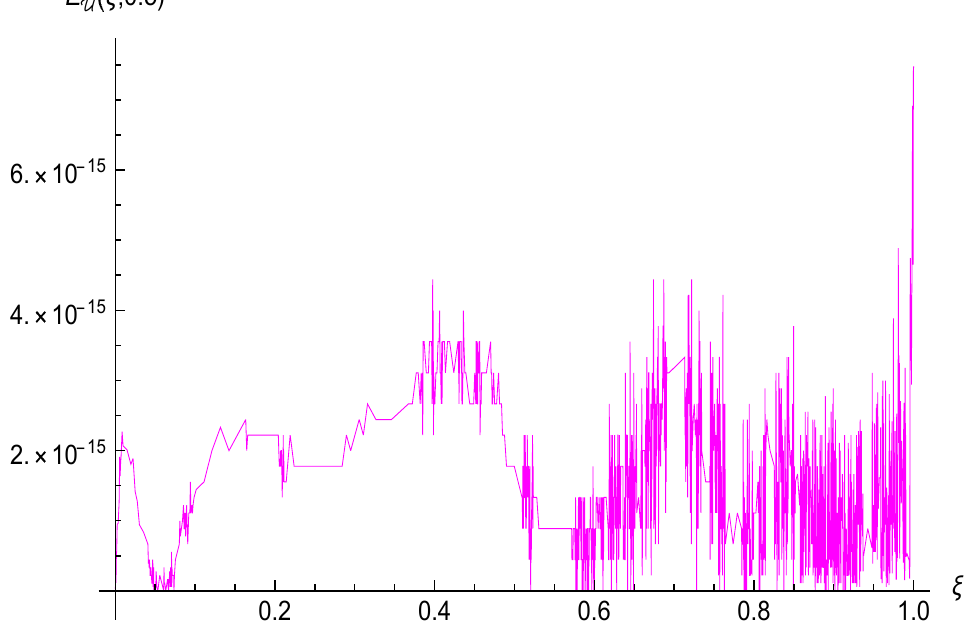
Figure 6. ξ -Absolute errors graph E U ( ξ ,0.5 ) of the problem (30), where σ 1 = (cid:36) 1 = σ 2 = (cid:36) 2 = 0, ν = 0.5 and N = M =